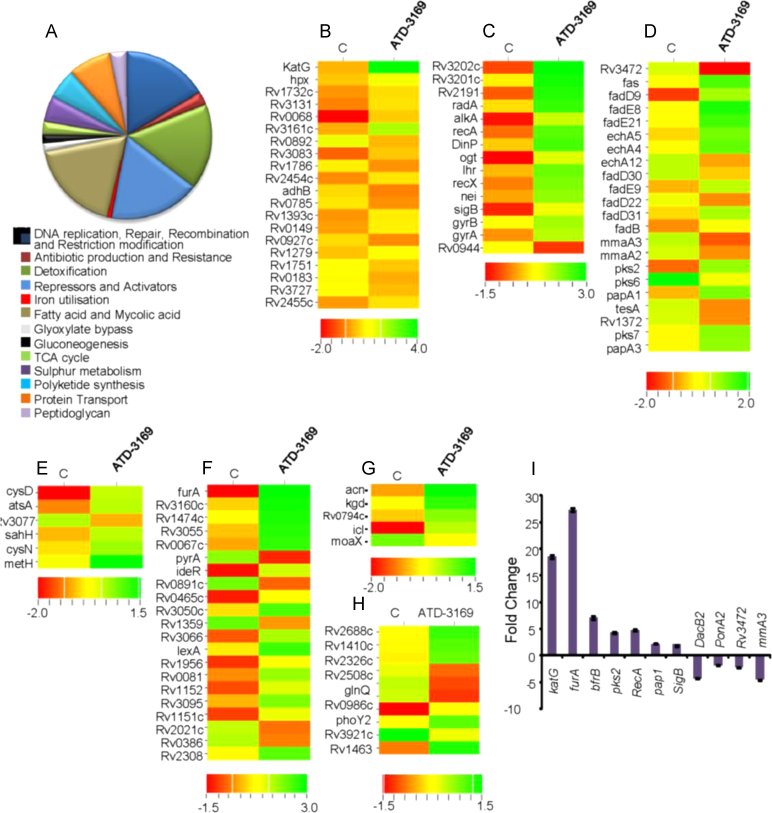
Global changes in the expression of Mtb H37Rv genes in response to ATD-3169. Mtb H37Rv was grown to an O.D600 nm of 0.4 and treated with 30 μM ATD-3169 for 4 h at 37 °C. Total RNA was isolated and subjected to microarray analysis as noted under Materials and methods. (A) Pie chart corresponding to differentially expressed genes in response to ATD-3169, functionally classified in 13 classes based on the annotation given in the tubercuList database. Differentially regulated genes were shown in the heat maps. (B) Detoxification, miscellaneous oxidoreductases, and oxygenases, (C) DNA replication, repair, recombination, and restriction/modification, (D) fatty acid catabolism and lipid anabolism, (E) sulfur metabolism, (F) transcriptional regulators, (G) TCA cycle and glyoxylate cycle genes, and (H) drug efflux pumps. (I) qRT-PCR validation of a select number of genes differentially regulated in the microarray data. Data shown are the representative of at least two difference experiments performed in triplicate. Error bars represents standard deviations from the mean.